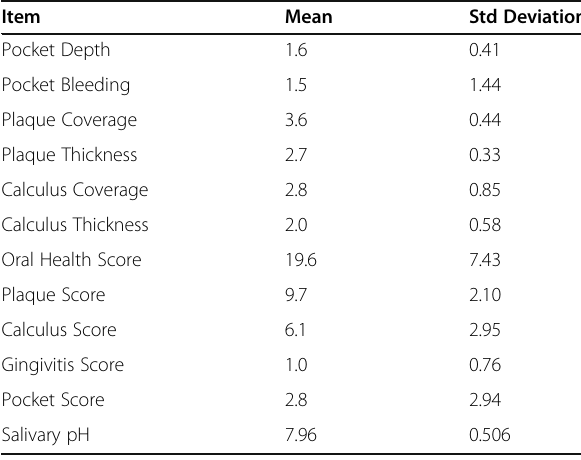
Table 1 Dental scoring and salivary pH from healthy adult